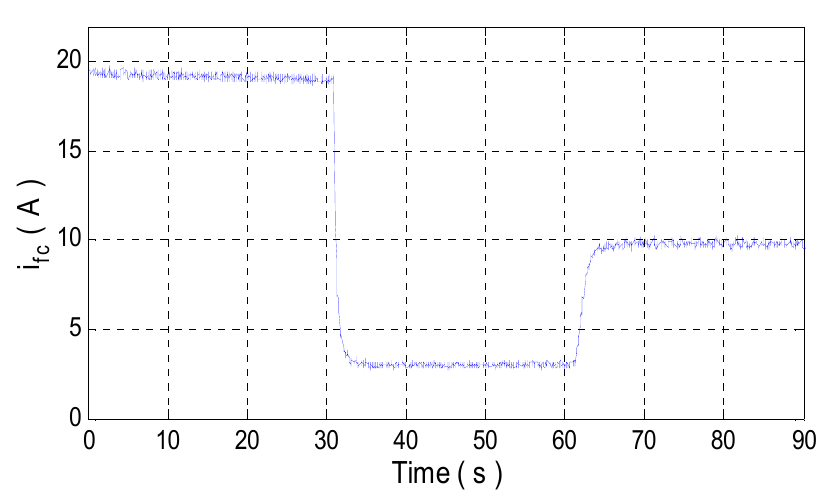
Figure 27. Fuel ‐ cell current i fc . Figure 27. Fuel-cell current i